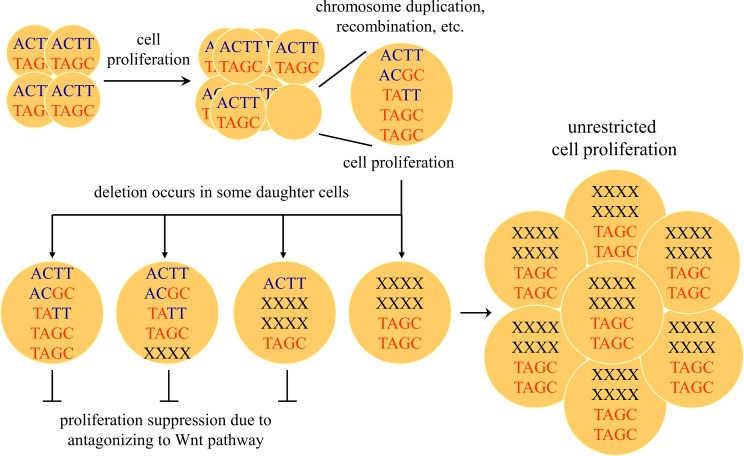
A model of HCC tumorigenesis showing the selective retention of the low transcriptional activity of DKK2 haplotype 1 (TAGC) allele.The cell proliferation rate is elevated in the pre-cancerous liver tissues, and a DNA break occurs near the recombination hotspots in the DKK2 promoter region, which leads to loss of the DKK2 alleles. In this scheme, those cells with low DKK2 transcriptional activity are selected for clonal amplification as a result of unchecked Wnt signaling.